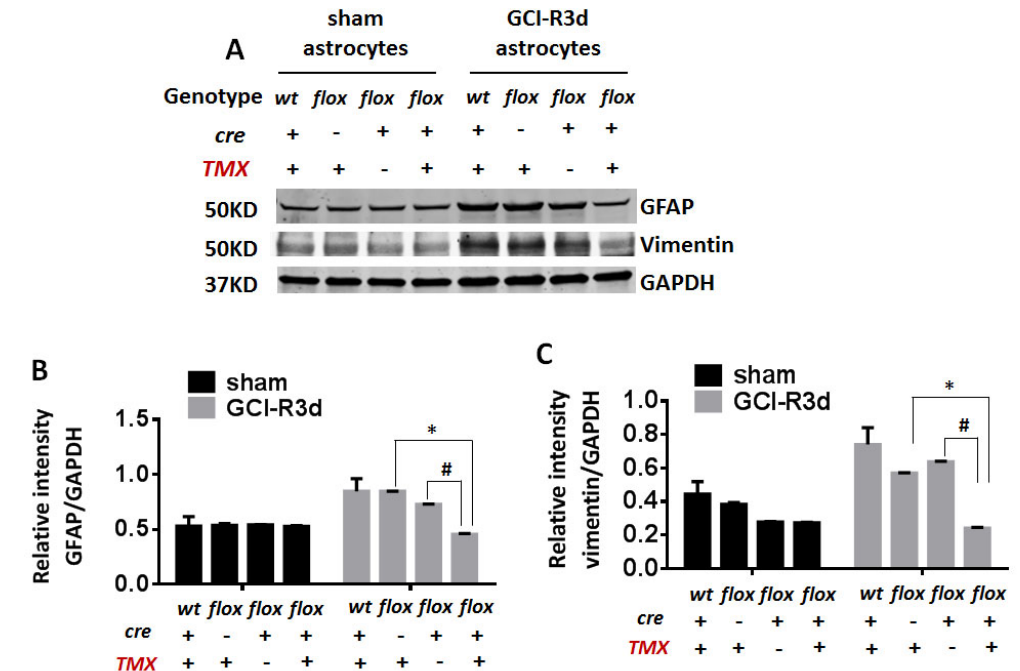
Figure 3. Decreased reactive astrogliosis in GFAP-ARO-iKO mice after GCI. Western blot analyses ( A ) on purified astrocytes lysate isolated from sham or GCI-R3d male mouse hemisphere and densitometry analysis demonstrated significant decrease in GFAP ( B ) and vimentin ( C ) expression in the astrocytes in GFAP-ARO-iKO mice at R3d. n = 6–8 animals/group. # p < 0.05 compared to TMX ( − ), and * p < 0.05 compared to cre ( − ), one-way ANOVA followed by post hoc.